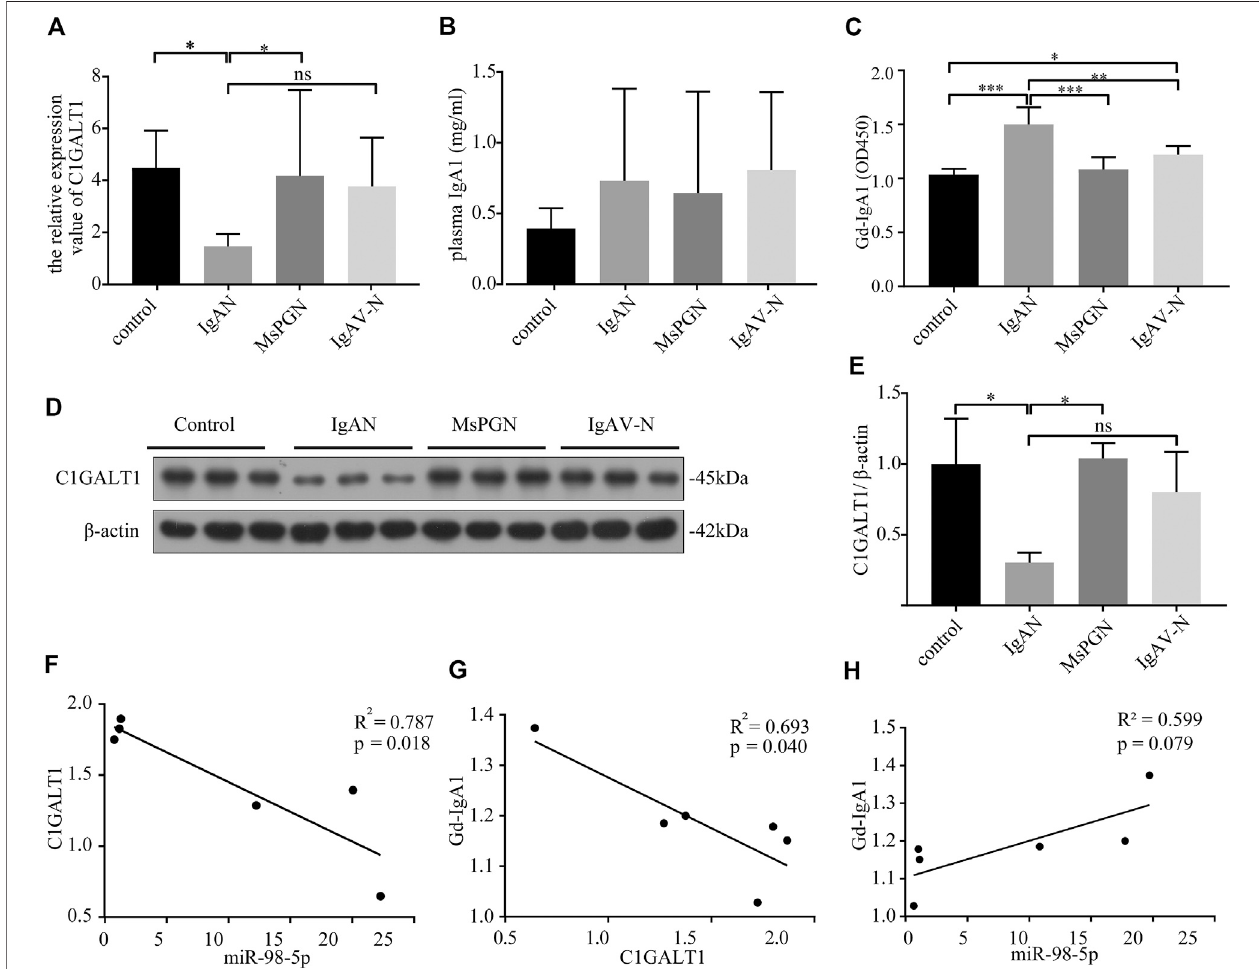
FIGURE 2 | The expression levels and relationships among miR-98-5p, C1GALT1, and Gd-IgA1 in IgAN. (A) The expression levels of C1GALT1 mRNA were analyzed by qRT-PCR. The expression levels in control, IgAN, MsPGN and IgAV-N groups were 4.50 ± 1.30, 1.47 ± 0.43, 4.17 ± 3.01 and 3.76 ± 1.71 respectively. (B) The plasma IgA1 level wasanalyzed byELISA, There were no signi fi cance between IgAN and other groups. (C) The relative level of Gd-IgA1 in the plasma was analyzed byVVA.TherelativelevelofGd-IgA1incontrol,IgAN,MsPGNandIgAV-Ngroupswere1.04 ± 0.05,1.50 ± 0.15,1.08 ± 0.10and1.22 ± 0.07respectively. (D) The expression ofC1GALT1 protein wasanalyzed byWestern blotting. (E) Fold changeswere calculated bydeterminingtheratios oftheC1GALT1/ β -actin band intensities. The semiquantitativerelativelevel ofC1GALT1protein incontrol, IgAN, MsPGNand IgAV-N groups were1.00 ± 0.26, 0.30 ± 0.06, 1.04 ± 0.09and 0.80 ± 0.23. (F) The relationship betweenC1GALT1and miR-98-5p. (G) TherelationshipbetweenGd-IgA1and themRNAofC1GALT1 (H) The relationship between Gd-IgA1and miR-98- 5p.Eachbarrepresentsthemean ± SDofsixcasesineachgroup.ns,nosigni fi cance;* p < 0.05,** p < 0.01,*** p < 0.001.Note:C1GALT1, β -1,3-galactosyltransferase; Gd-IgA1, galactose-de fi cient IgA1; IgAN, IgA nephropathy; qRT-PCR, quantitative real-time polymerase chain reaction; ELISA, enzyme-linked immunosorbent assay; VVA, Vicia Villosa lectin-binding assay; SD, standard